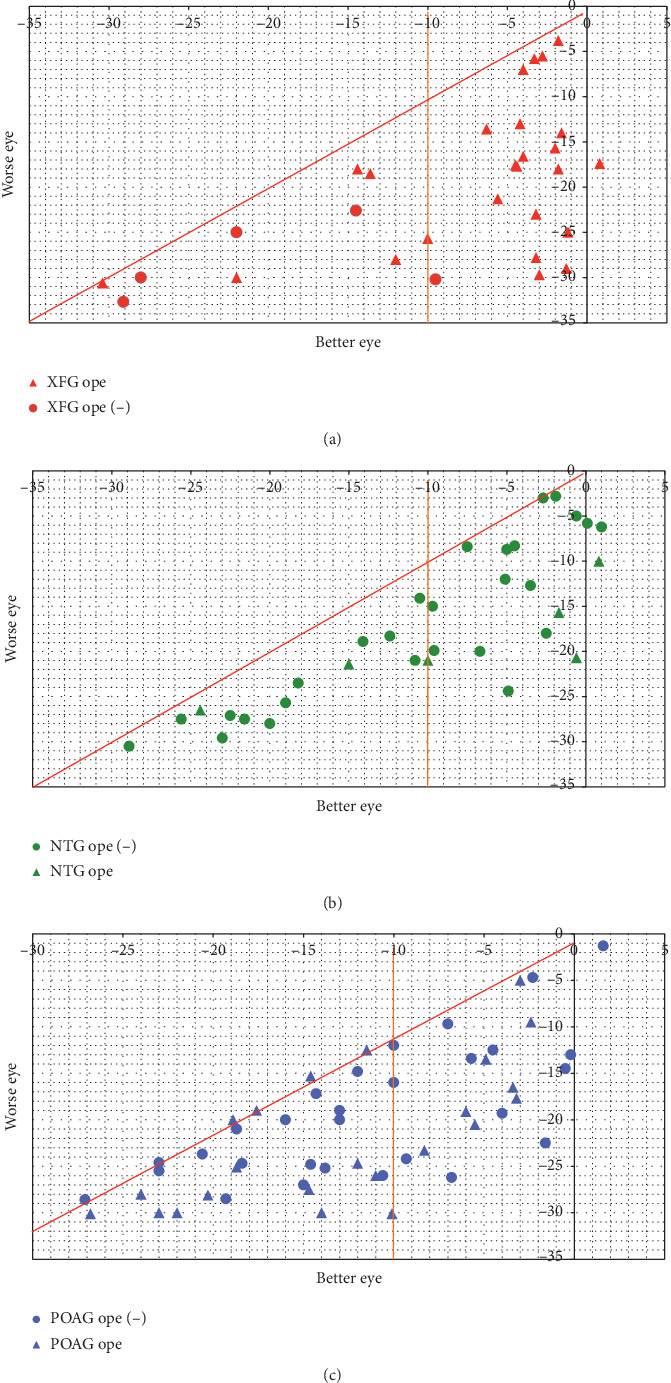
(a) Scatter plot of the Humphrey visual field 24-2 or 30-2 program and Swedish Interactive Thresholding Algorithm standard values for the better eye and worse eye, with mean deviation values of XFG and indication for surgery (yes/no). (b). Scatter plot of the Humphrey visual field 24-2 or 30-2 program and Swedish Interactive Thresholding Algorithm standard values for the better eye and worse eye, with mean deviation values of NTG and indication for surgery (yes/no). (c). Scatter plot of the Humphrey visual field 24-2 or 30-2 program and Swedish Interactive Thresholding Algorithm standard values for the better eye and worse eye, with mean deviation values of POAG and indication for surgery (yes/no).